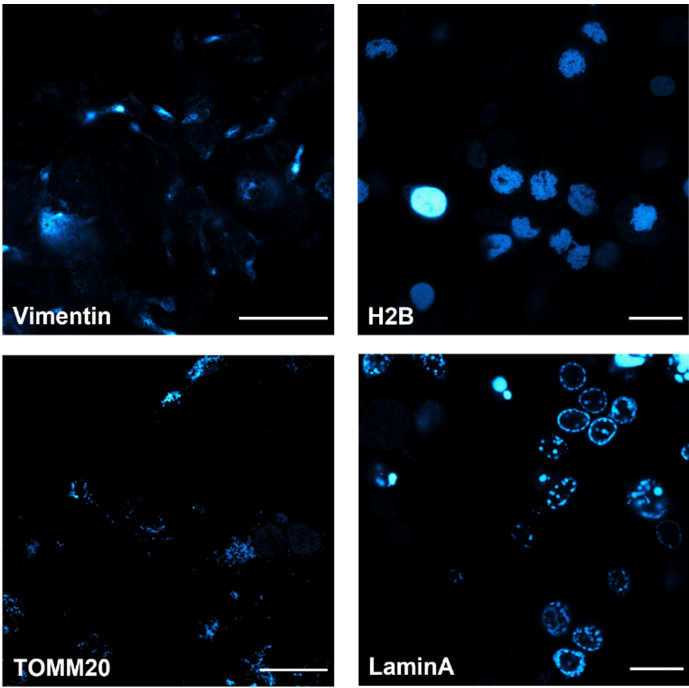
Figure 6. Confocal microscopy images of Vimentin-HaloTag, H2B-HaloTag, TOMM20-HaloTag and LaminA-HaloTag, expressing HEK293T cells treated with HaloBCN (3 µ M) and SiR-Tet (3 µ M) Spectral detection: λ exc : 638 nm/ λ em : 650–800 nm; Scale bar = 25 μ m.